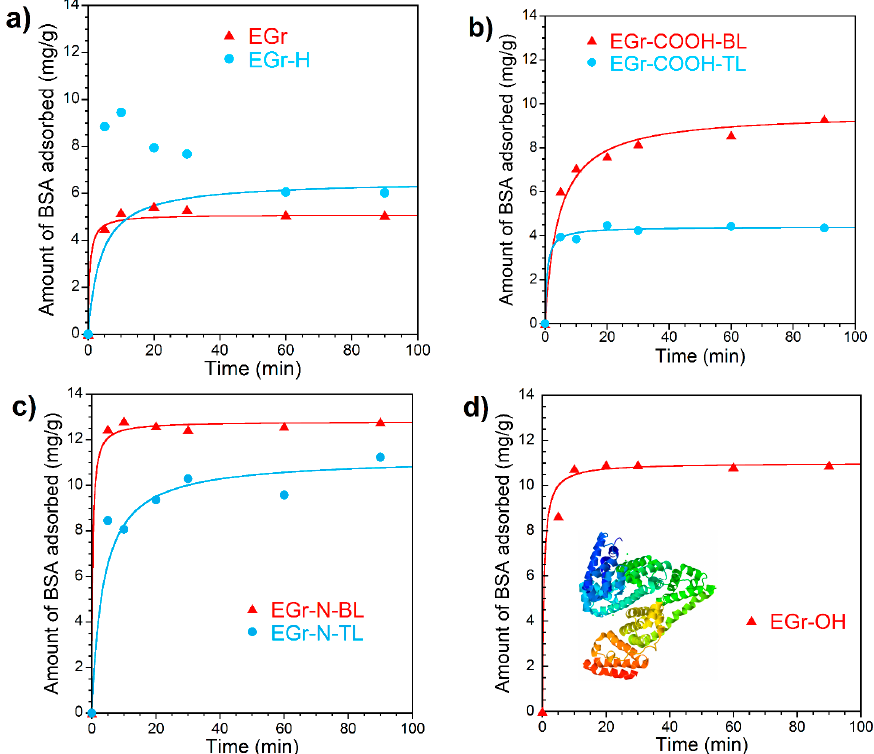
Figure 4. The kinetics of bovine serum albumin (BSA) adsorption from phosphate-buffered saline (PBS): ( a ) on as-received (EGr) and heated at 900 °C (EGr-H); ( b ) carboxylated (EGr-COOH); ( c ) aminated (EGr-N) and ( d ) hydroxylated (EGr-OH) expanded graphite samples (mass loading ~100 mg; initial concentration of BSA 1 mg/mL; liquid phase volume 5 mL). Inset in Figure 4d is the crystal structure of Bovine Serum Albumin [36]. The experimental data was fitted using the pseudo-second-order kinetic model.